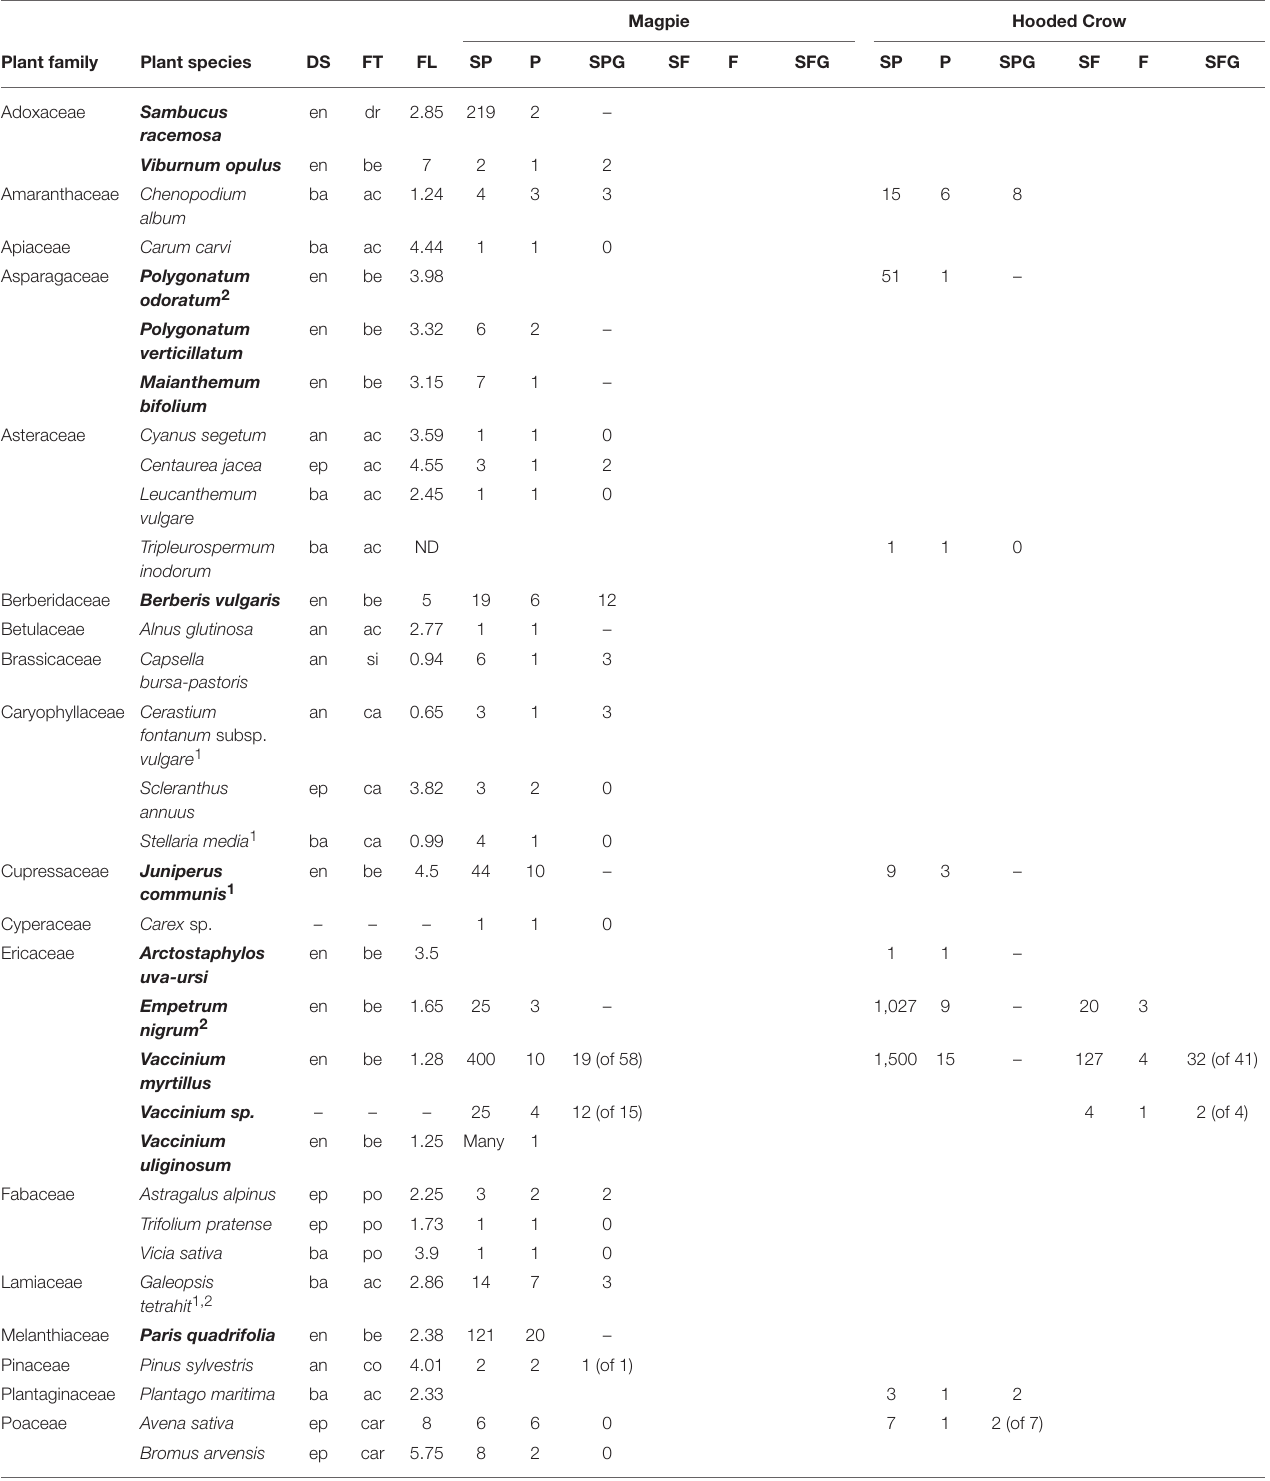
TABLE 1 | Abundance and frequencies of different plant taxa recovered by Heintze from the pellets and feces of Magpies and Hooded Crows, showing: Dispersal syndrome (DS, an, anemochory; ba, barochory; en, endozoochory; ep, epizoochory), Fruit type (FT, ac, achene; be, berry; ca, capsule; car, caryopsis; co, cone; dr, drupe; po, pod; si, silique), Fruit length (FL), Number of intact seeds in pellets (SP), Number of pellets containing seeds (P), Number of seeds germinated from pellets (SPG), Number of intact seeds found in feces (SF), Number of fecal samples containing seeds (F), Number of seeds germinated from fecal samples (SFG).